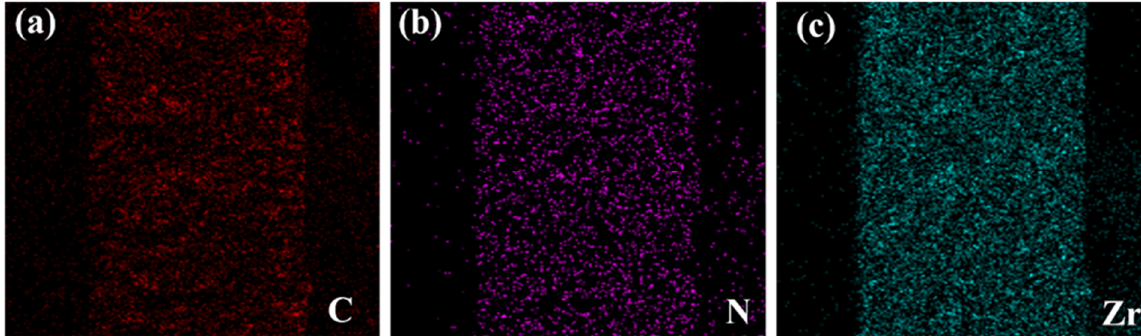
Figure 4. EDS of ( a ) C, ( b ) N, and ( c ) Zr elemental mapping of PVAm-PVA-UiO-66-NH 2 .